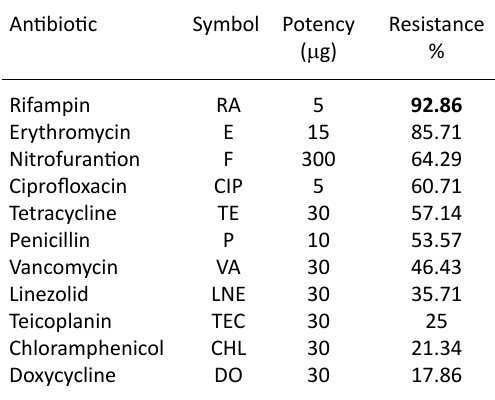
Table 1. Antibiotics resistance percentage among Enterococcus spp.